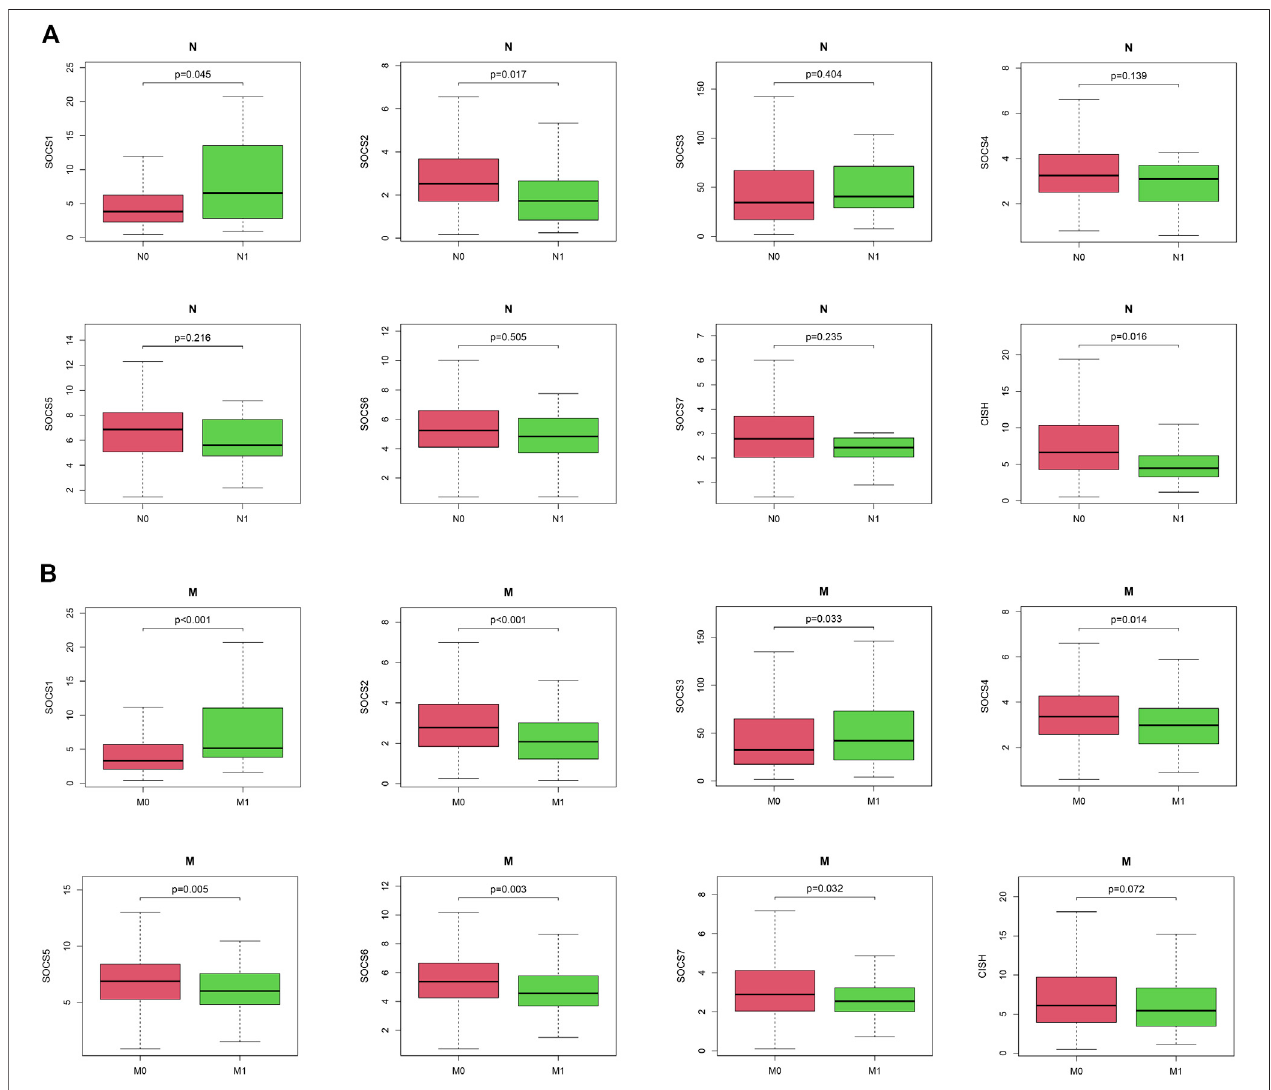
FIGURE 2 | Correlation between expression levels of SOCS genes and different clinicopathological features in patients with KIRC. (A) Correlation between expression level of each SOCS family member and N stage. (B) Correlation between expression level of SOCS family members and M stage.